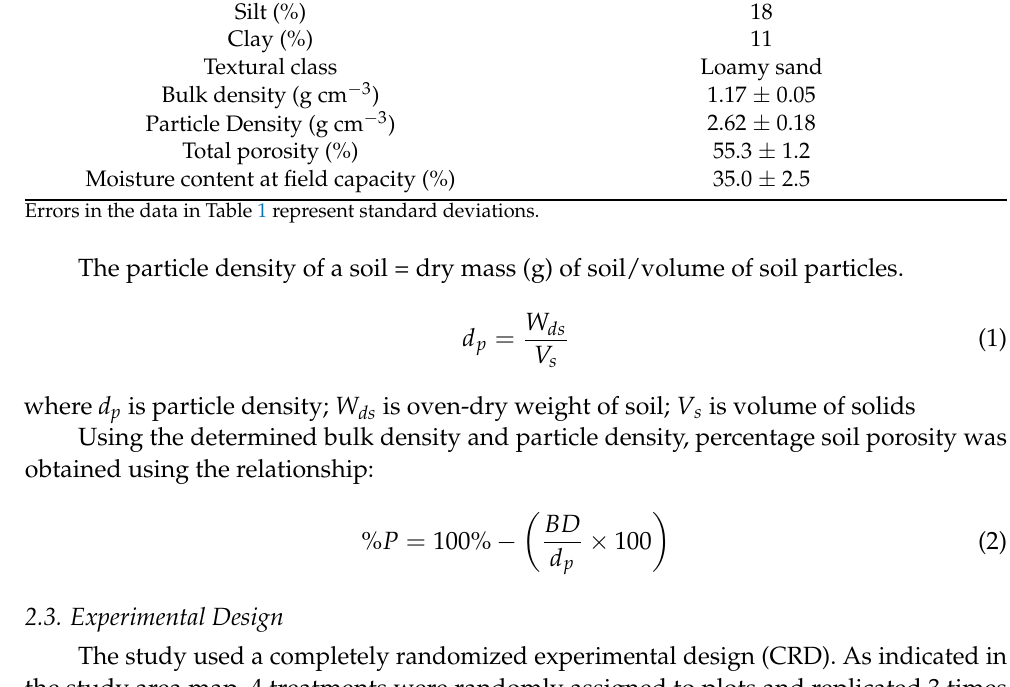
Table 1. General physical characteristic statuses of the plots before interventions. Factor Value Sand (%) 71 Silt (%) 18 Clay (%) 11 Textural class Loamy sand Bulk density (g cm − 3 ) 1.17 ± 0.05 Particle Density (g cm − 3 ) 2.62 ± 0.18 Total porosity (%) 55.3 ± 1.2 Moisture content at field capacity (%) 35.0 ± 2.5 Errors in the data in Table 1 represent standard